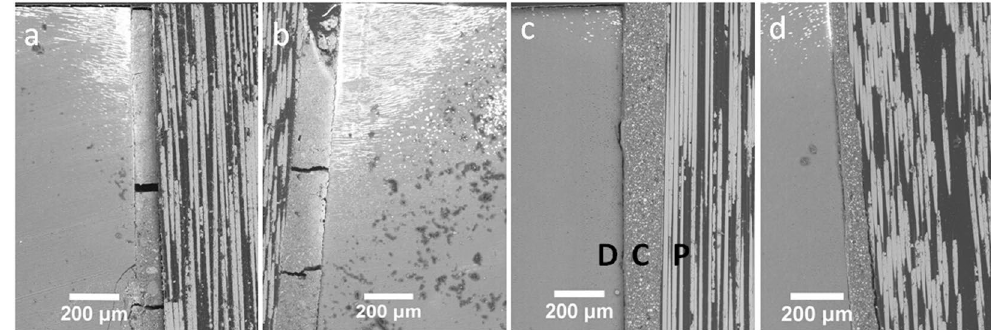
Figure 4. SEM images of post-dentin disks after silver nitrate penetration. ( a ) RMGI with PBS. ( b ) RMGI with TC. ( c ) Resin cement with PBS. ( d ) Resin cement with TC. P, post; C, cement; D, dentin.